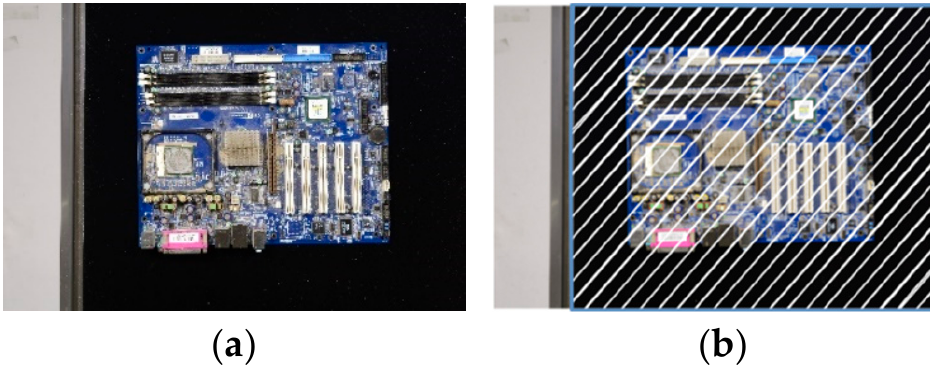
Figure 2. An image sample from the Printed circuit boards digital single ‐ lens reflex (PCB DSLR) Dataset ( a ) and the region of interest hatchured ( b ).